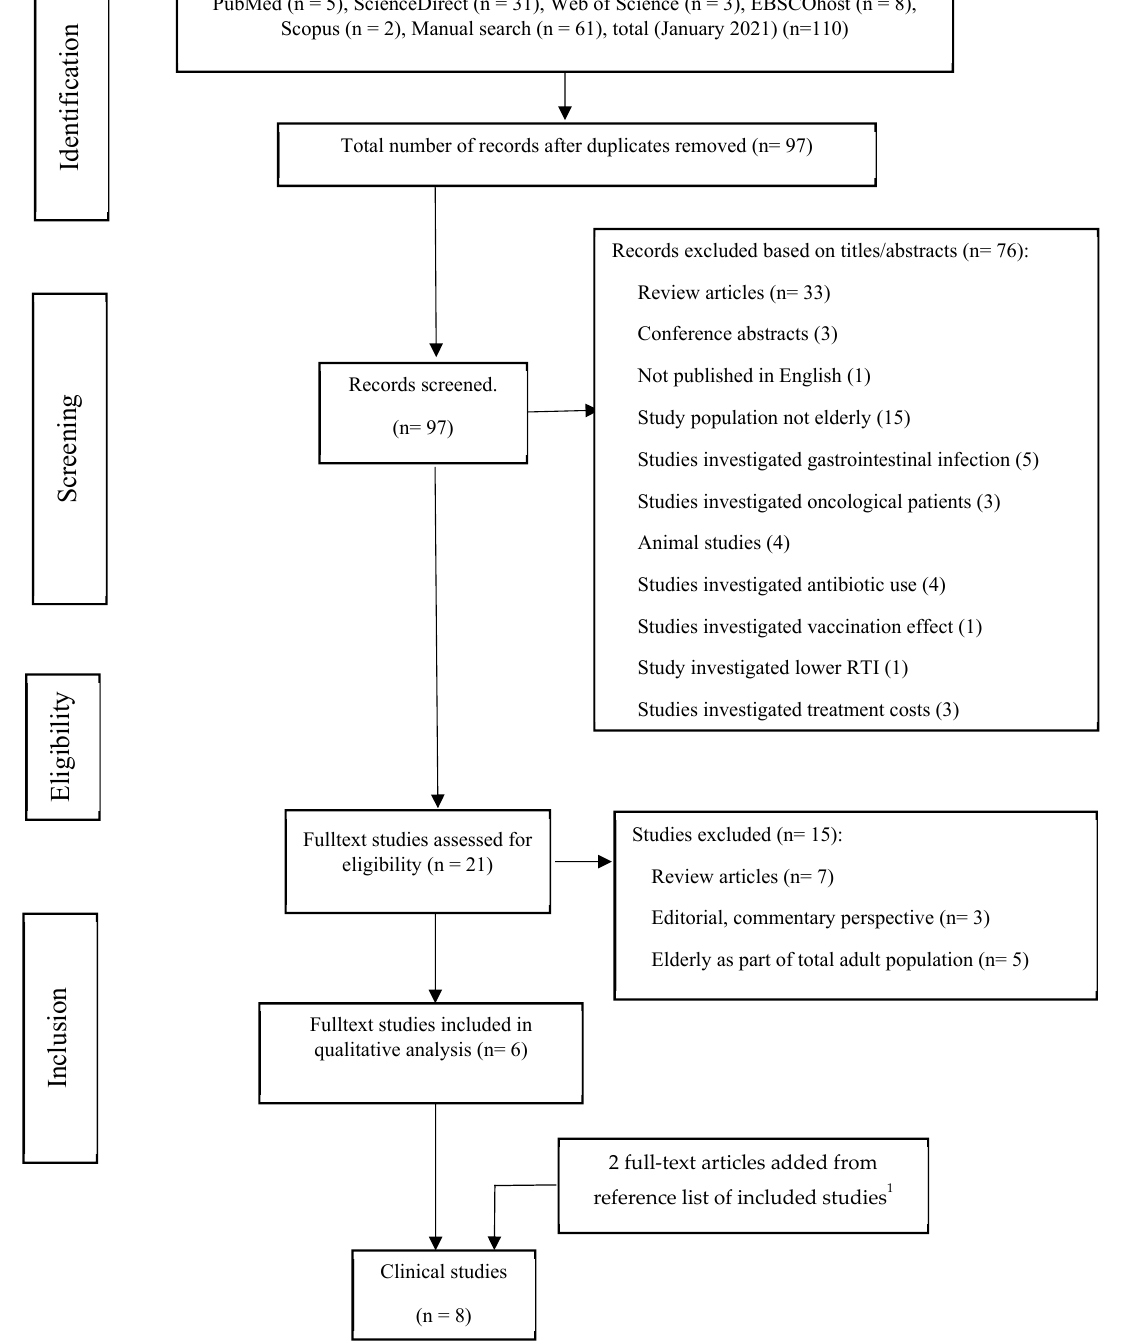
Figure 1. Flow chart of literature search procedure according to the PRISMA statement [48]. 1 two references identified from the reference lists